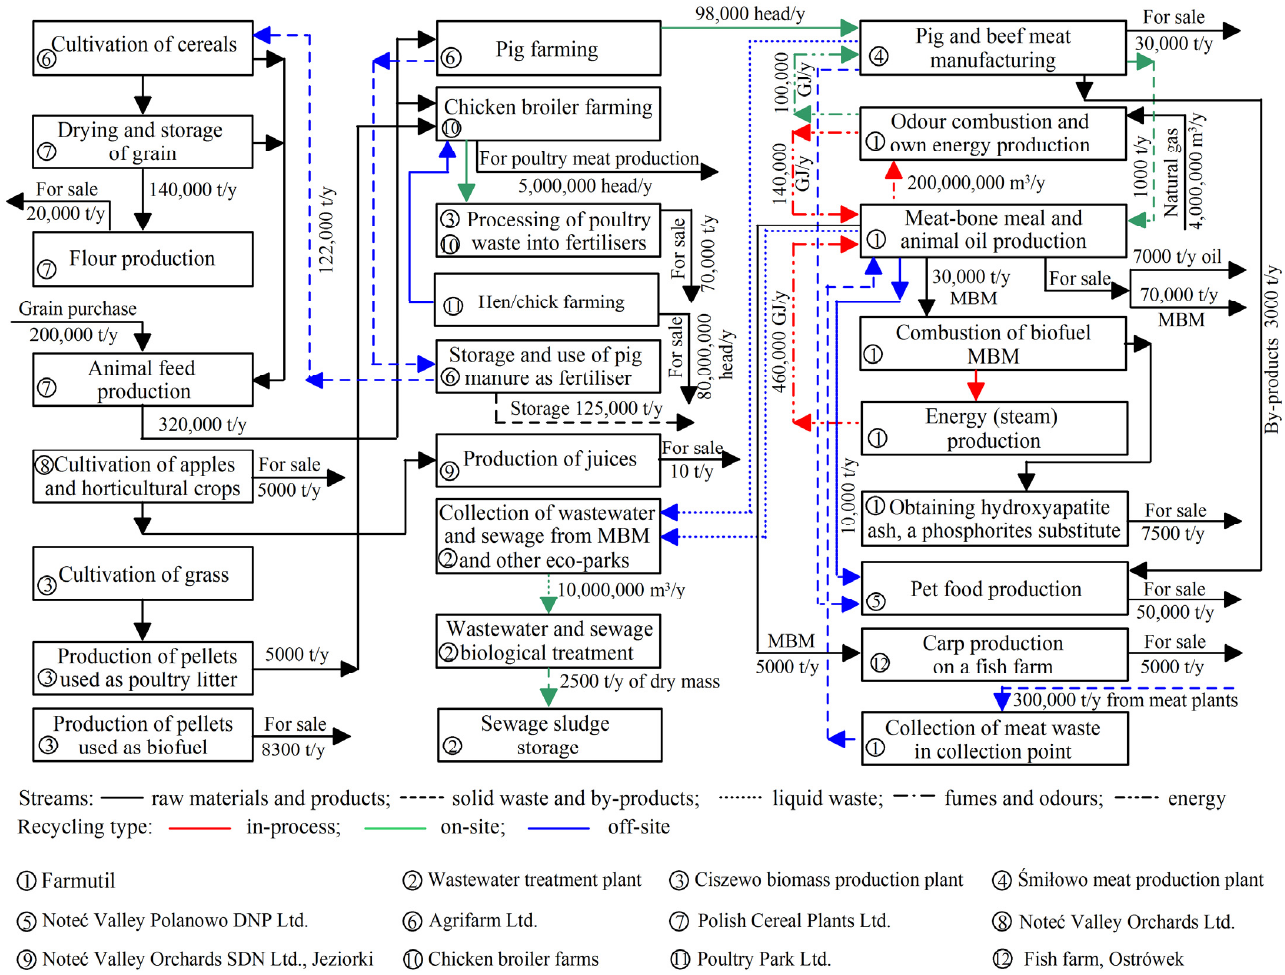
Figure 2. Exchange flows of materials and utilities in the ´Smiłowo EIP production units. Central Power Station (modernized in last 3 years secures electricity demand for Eco- Farmutil Inc. (´Smiłowo, Poland) in ´Smiłowo is the biggest EIP company that park production and auxiliary units.